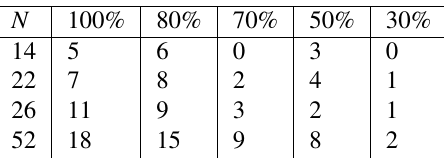
Table 5. Working rate of